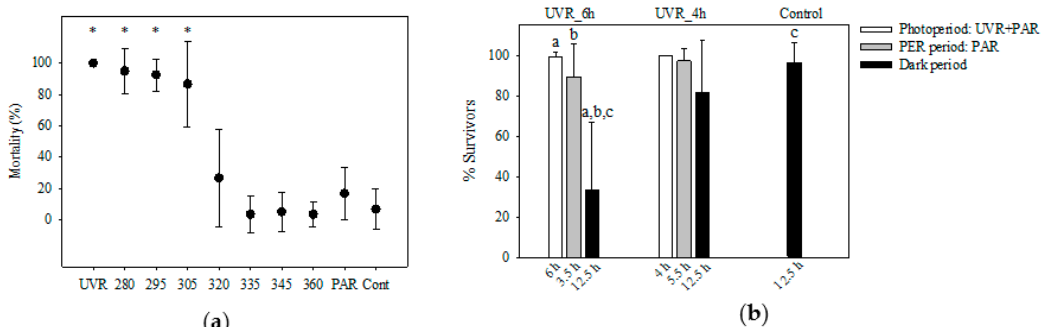
Figure 3. ( a ) Mortality (% ± std) of Pelagodileptus trachelioides 24 h after T0 (exp 1 and 2): The experimental treatments were UVR, 280, 295, 305, 320, 335, 345, and 360 nm, PAR, and control (Cont). Data of three individual experiments were pooled ( n = 60 for all treatments, except for 280 and 295 nm with n = 40). * indicates significant mortality against the control ( p ≤ 0.001). ( b ) Means of the surviving individuals (% ± std) of P. trachelioides after experimental exposure to UVR_4h (without UVR after 4 h) and UVR_6h (without UVR after 6 h) and in the control (exp 3). X-axis: duration (h) of the UVR + PAR period, the photoenzymatic repair (PER) period (without UVR), and the dark period. a, b, and c indicate significant mortality ( p < 0.05) between treatments.